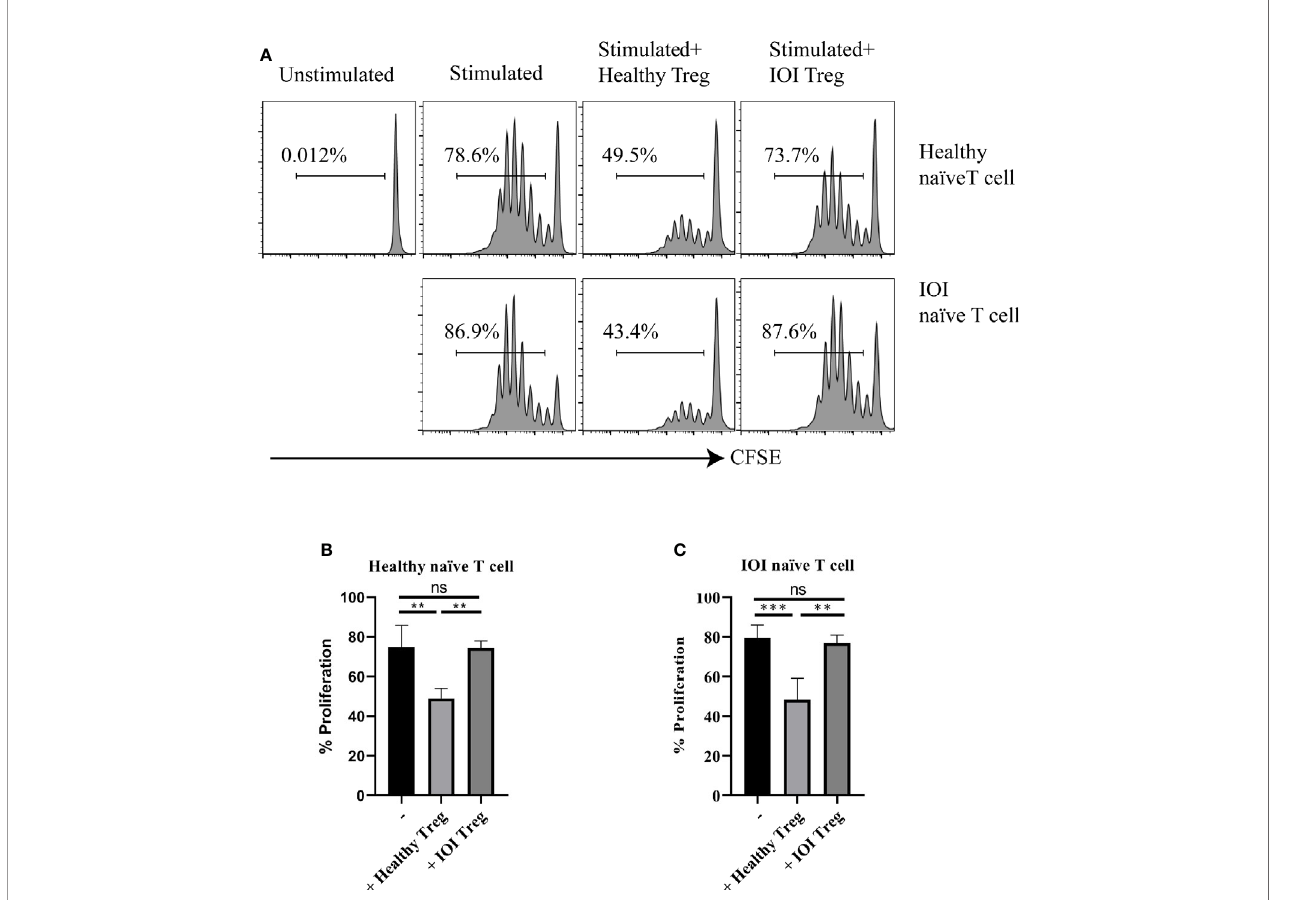
FIGURE 3 | The suppressive function of Tregs invitro. Sorted-Tregs were cocultured with CFSE labeled naïve T cells. The proliferation of naïve T cells were examined after 5 days. (A) is one representative image. (B, C) is statistical images. ** P < 0.01; *** P < 0.001; ns, not signi fi